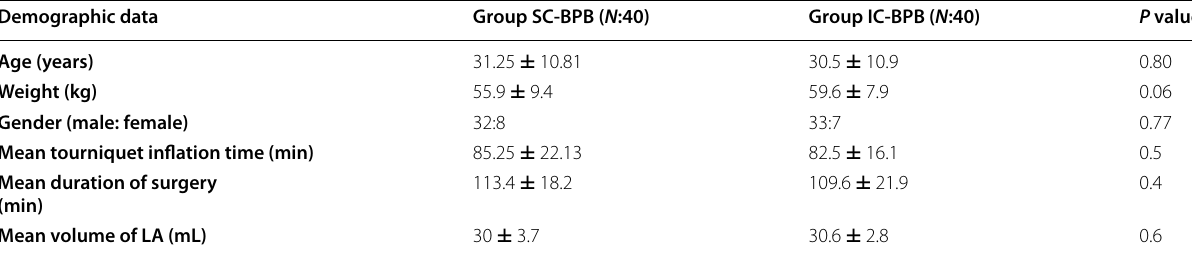
Age, weight, tourniquet time, duration of surgery, and volume of local anesthetic are presented as mean t test. Gender is presented numbers and is compared using chi-square test. A P value of 0.05 or less is significant